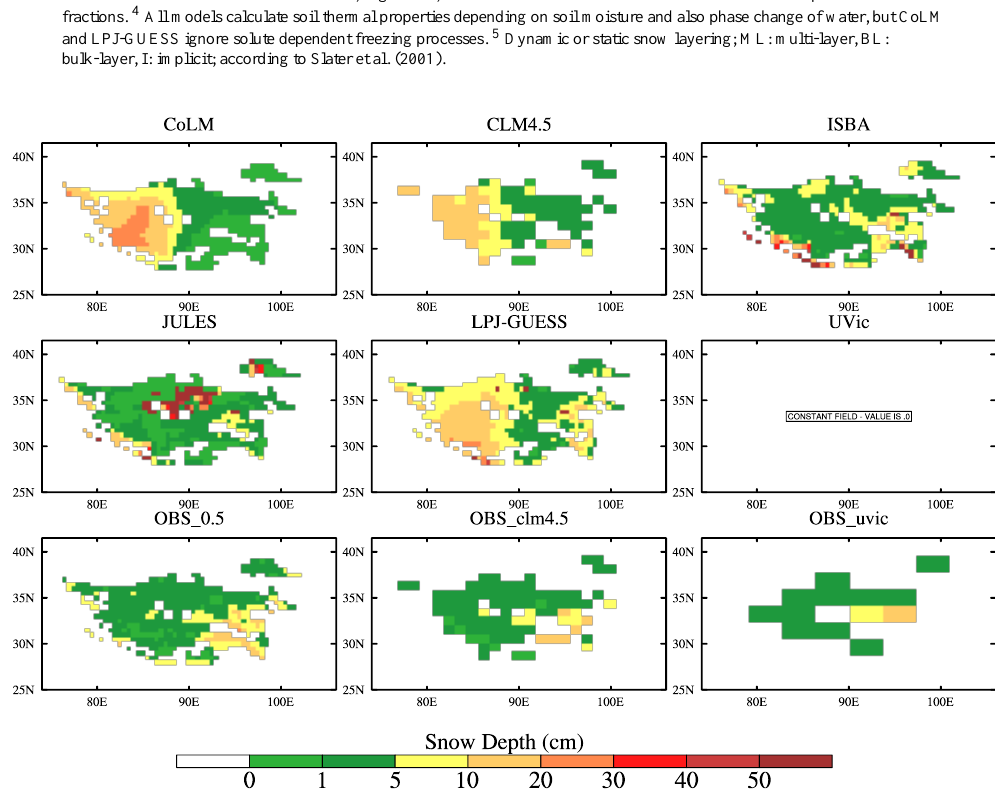
Figure 6. Winter snow depth for the common region, averaged over 1980–2000. Note the nonlinear color scale. We use the Long Time-Series Snow Data Set of China (Che et al., 2008; http://westdc.westgis.ac.cn) as the observed snow depth. The observed snow depth plot is further interpolated onto the models’ resolutions as “OBS_”. The OBS_05 is in 0.5 ◦ resolution for CoLM, ISBA, JULES and LPJ-GUESS. The OBS_CLM4.5 and OBS_UVic are in the resolutions of CLM4.5 and UVic